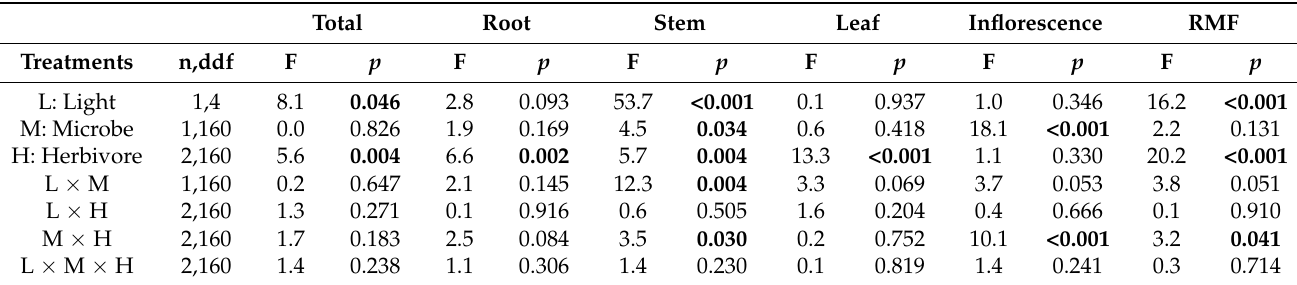
All values in bold indicate differences significant at p < 0.05. Light quality and microbe treatment had no effect on leaf biomass, but herbivores significantly reduced leaf biomass (F (2,160) = 5.7, p = 0.004; Table 2) and increased root dry biomass (F (2,160) = 6.6, p = 0.002), resulting in an increased root weight ratio especially in the presence of mycorrhizae. A negative correlation between total shoot biomass and the plants (Figure S3) but not in other treatments. There was no significant three-way